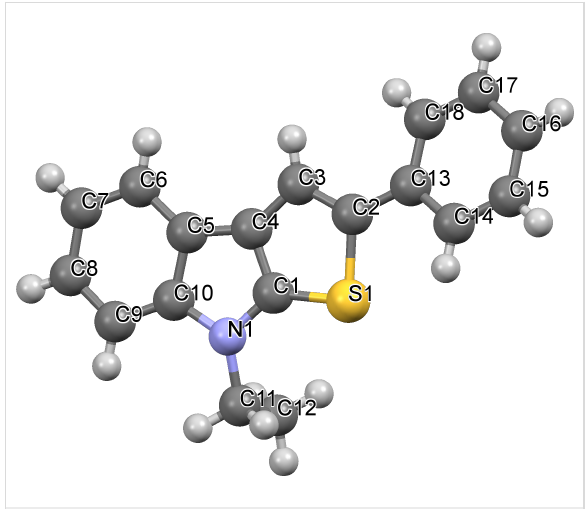
Figure 2: Mercury [34] representation of the X-ray crystal structure of 12a . Thermal ellipsoids of 50% probability are presented.